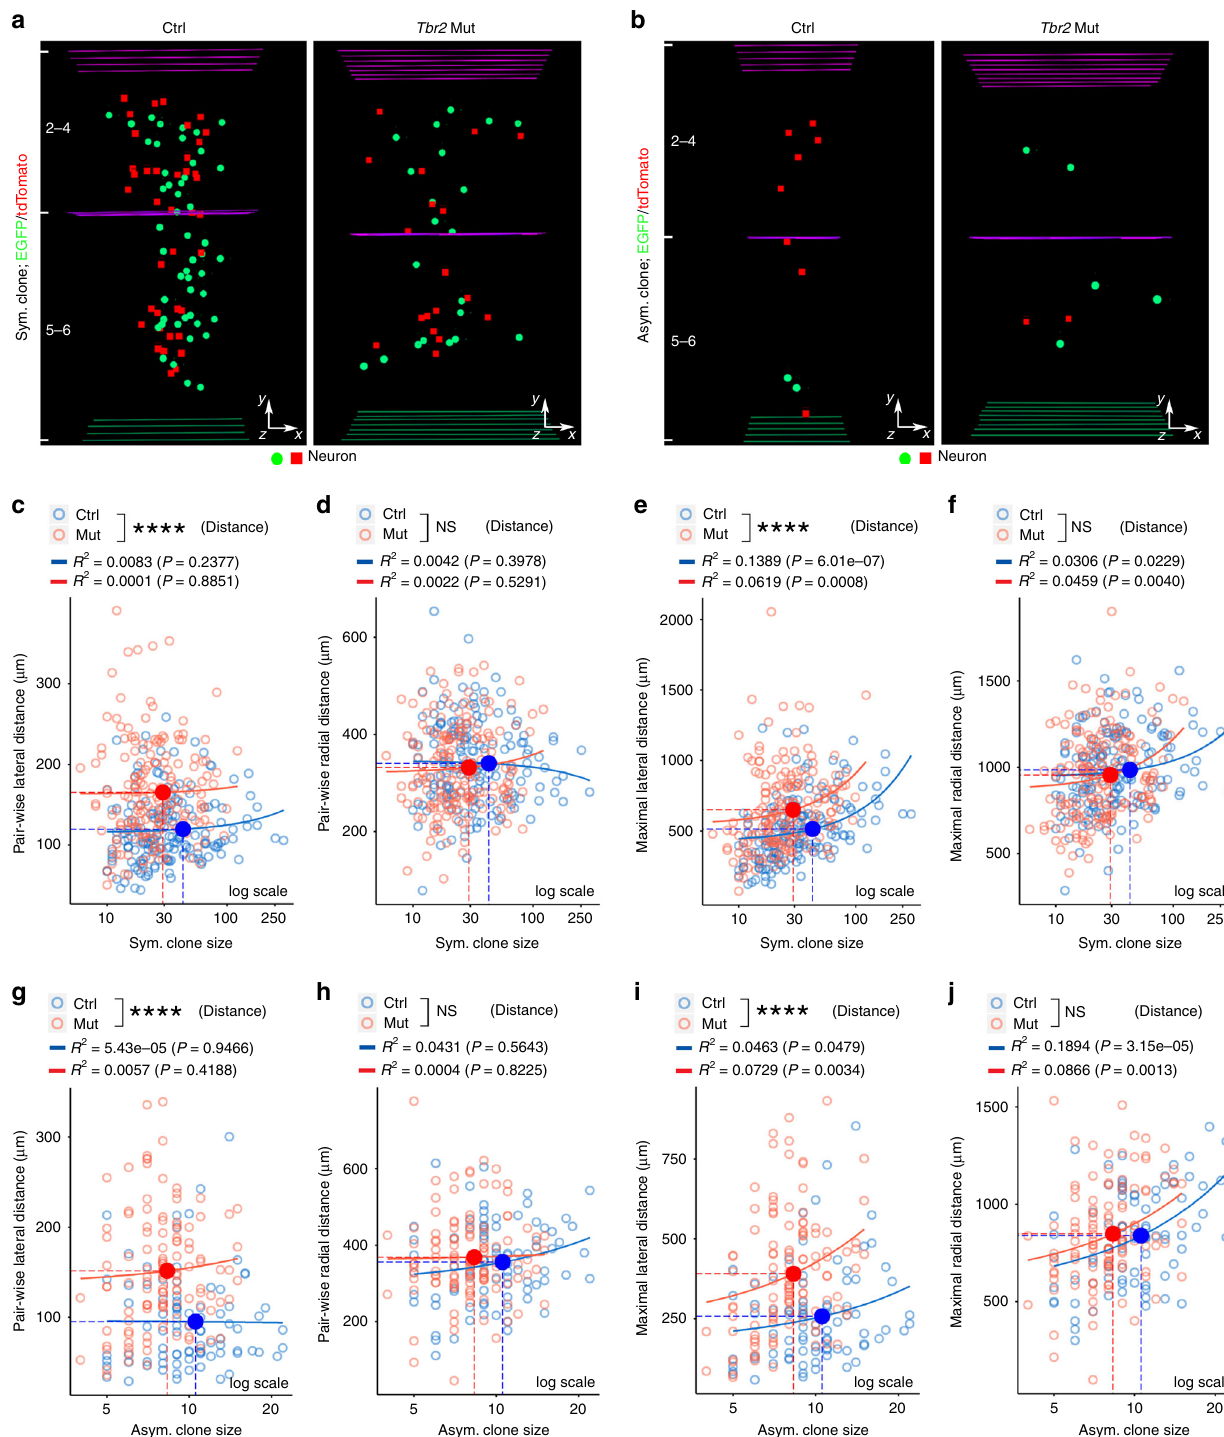
Fig. 2 TBR2 removal causes a lateral dispersion of clonally related excitatory neurons. a , b 3D reconstruction images of representative P21 Ctrl (left) and Tbr2 Mut (right) symmetric ( a ) and asymmetric ( b ) MADM clones. c – f Quanti fi cation of the pair-wise ( c , d ) and maximal ( e , f ) lateral and radial distances between neurons in symmetric Ctrl (blue) and Tbr2 Mut (red) clones (Ctrl, n = 169; Mut, n = 177). The X -axis is in log scale. Each open circle represents an individual clone and the fi lled circles and broken lines indicate the means of distances and clone sizes of each group. The solid lines represent linear regression between clone size and distances of each group. Similar displays are used in subsequent fi gures. g – j , Quanti fi cation of the pair-wise ( g , h ) and maximal ( i , j ) lateral and radial distances between neurons in asymmetric Ctrl and Tbr2 Mut clones (Ctrl, n = 85; Mut, n = 116). Data are presented as mean ± SEM (**** P < 0.0001; NS not signi fi cant; unpaired Student ’ s t